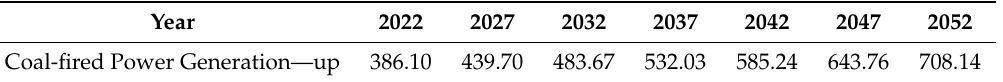
Table 7. Consumption bounds for coal-fired power generation in the NODIESEL_T scenario (PJ).